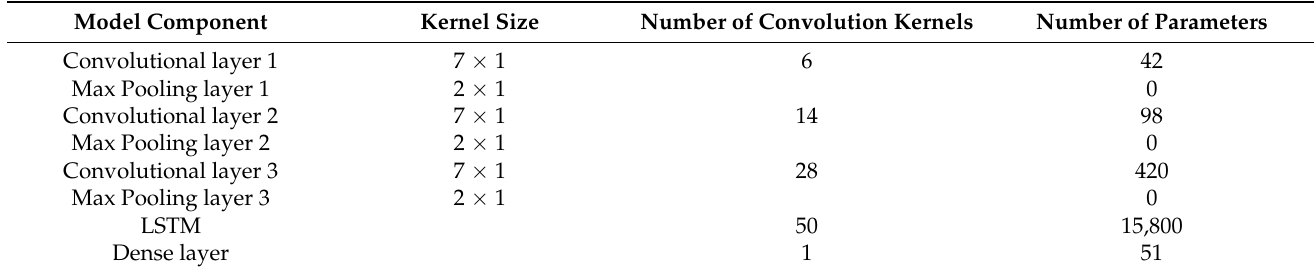
Table 3. The MTL-CNN-LSTM model hyperparameter